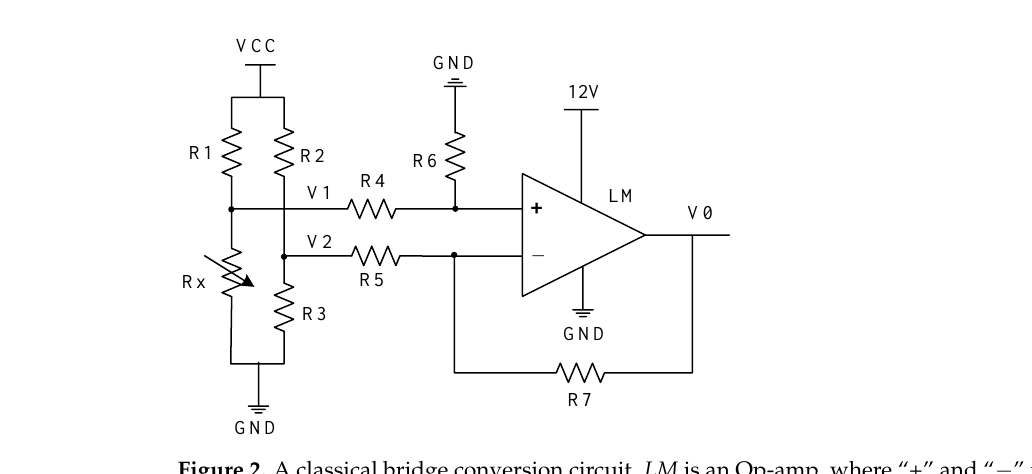
Figure 2. A classical bridge conversion circuit. LM is an Op-amp, where “+” and “ − ” represent the corresponding noninverting and inverting inputs, respectively.